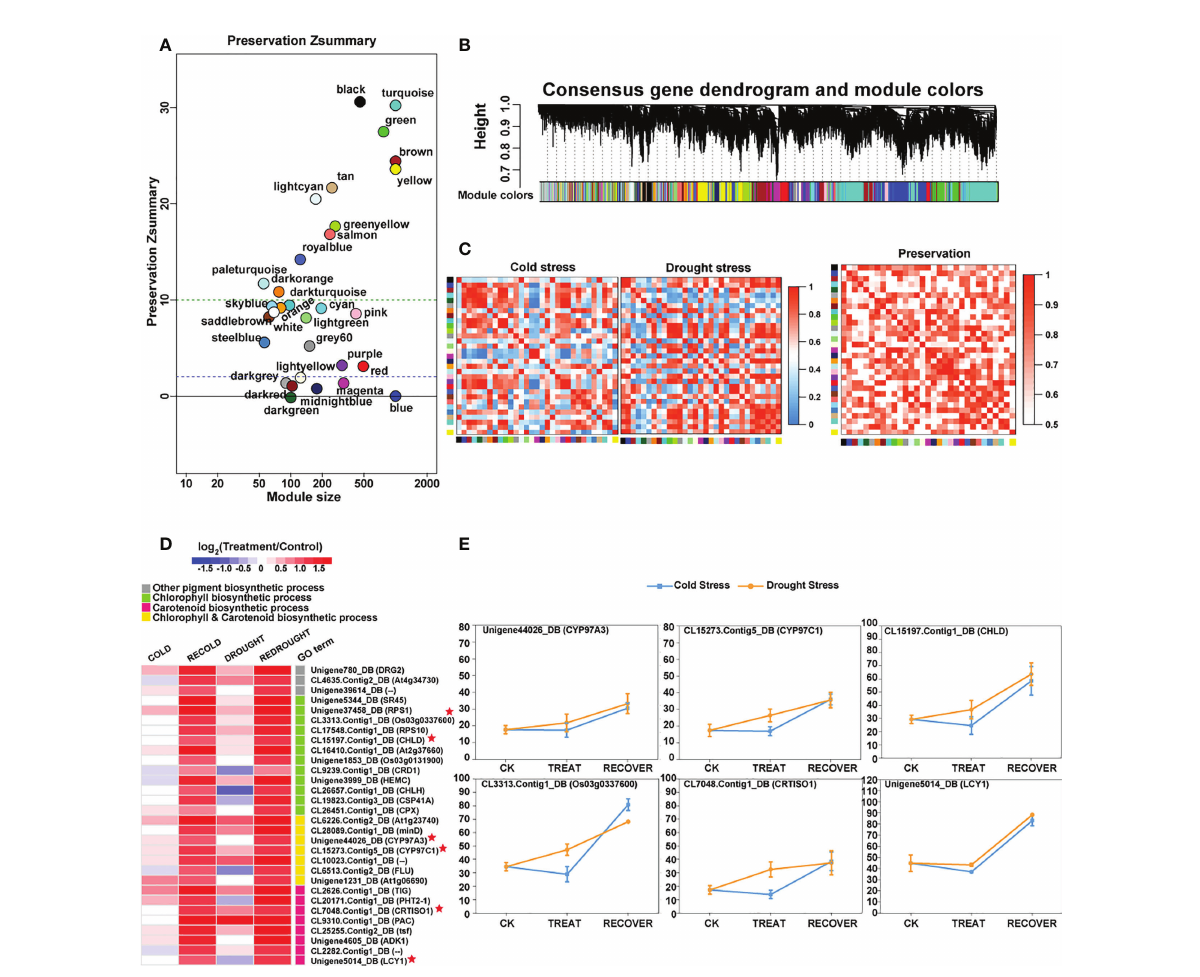
FIGURE 6 The preservation of consensus modules (CMs) and the functions of CM core genes. (A) The preservation results of CMs. The vertical axis represents the Z -score, and the horizontal axis denotes the module size. (B) Hierarchical cluster dendrogram showing consensus gene co- expression modules. In the dendrogram, each leaf represents one gene, and each module below the dendrogram is labeled with one color. (C) Heat maps of eigengene networks showing the relationships among CMs in cold and drought stress. The preservation heat map shows the preservation network, de fi ned as one minus the absolute difference of the eigengene networks in both sets, and the barplot depicts the mean preservation of adjacency for each of the eigengenes to all other eigengenes. (D) The expression pro fi le of the important core genes. In the heat map, color intensity represents the coef fi cients calculated by expression pattern analysis, and different GO terms are represented by different colors. Some genes marked with red stars as the characterization of each GO term show expression trends in line graphs. (E) The line graphs of some function genes with a star mark related to photosynthetic pigment biosynthesis. Drought stress is represented by a yellow line, and cold stress is shown by a blue line. The horizontal axis denotes the sampling points, and the vertical coordinates re fl ect the gene expression level (FPKM